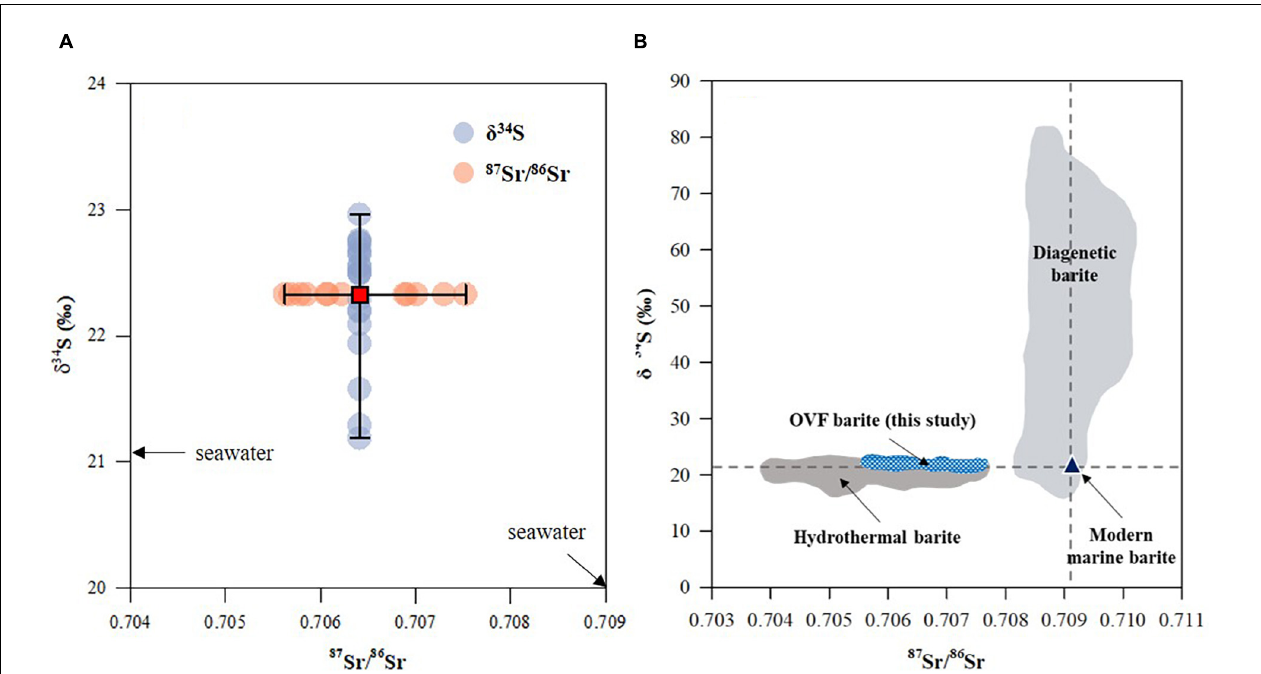
FIGURE 7 | (A) Strontium ( 87 Sr/ 86 Sr) and sulfur ( δ 34 S) isotopic compositions of the OVF barite samples. (B) Plot of Sr and S isotope values for discriminating the origin of barite (after Eickmann et al., 2014). Note that the OVF barite samples plotted in the field of known hydrothermal barite and were clearly distinctive from the diagenetic